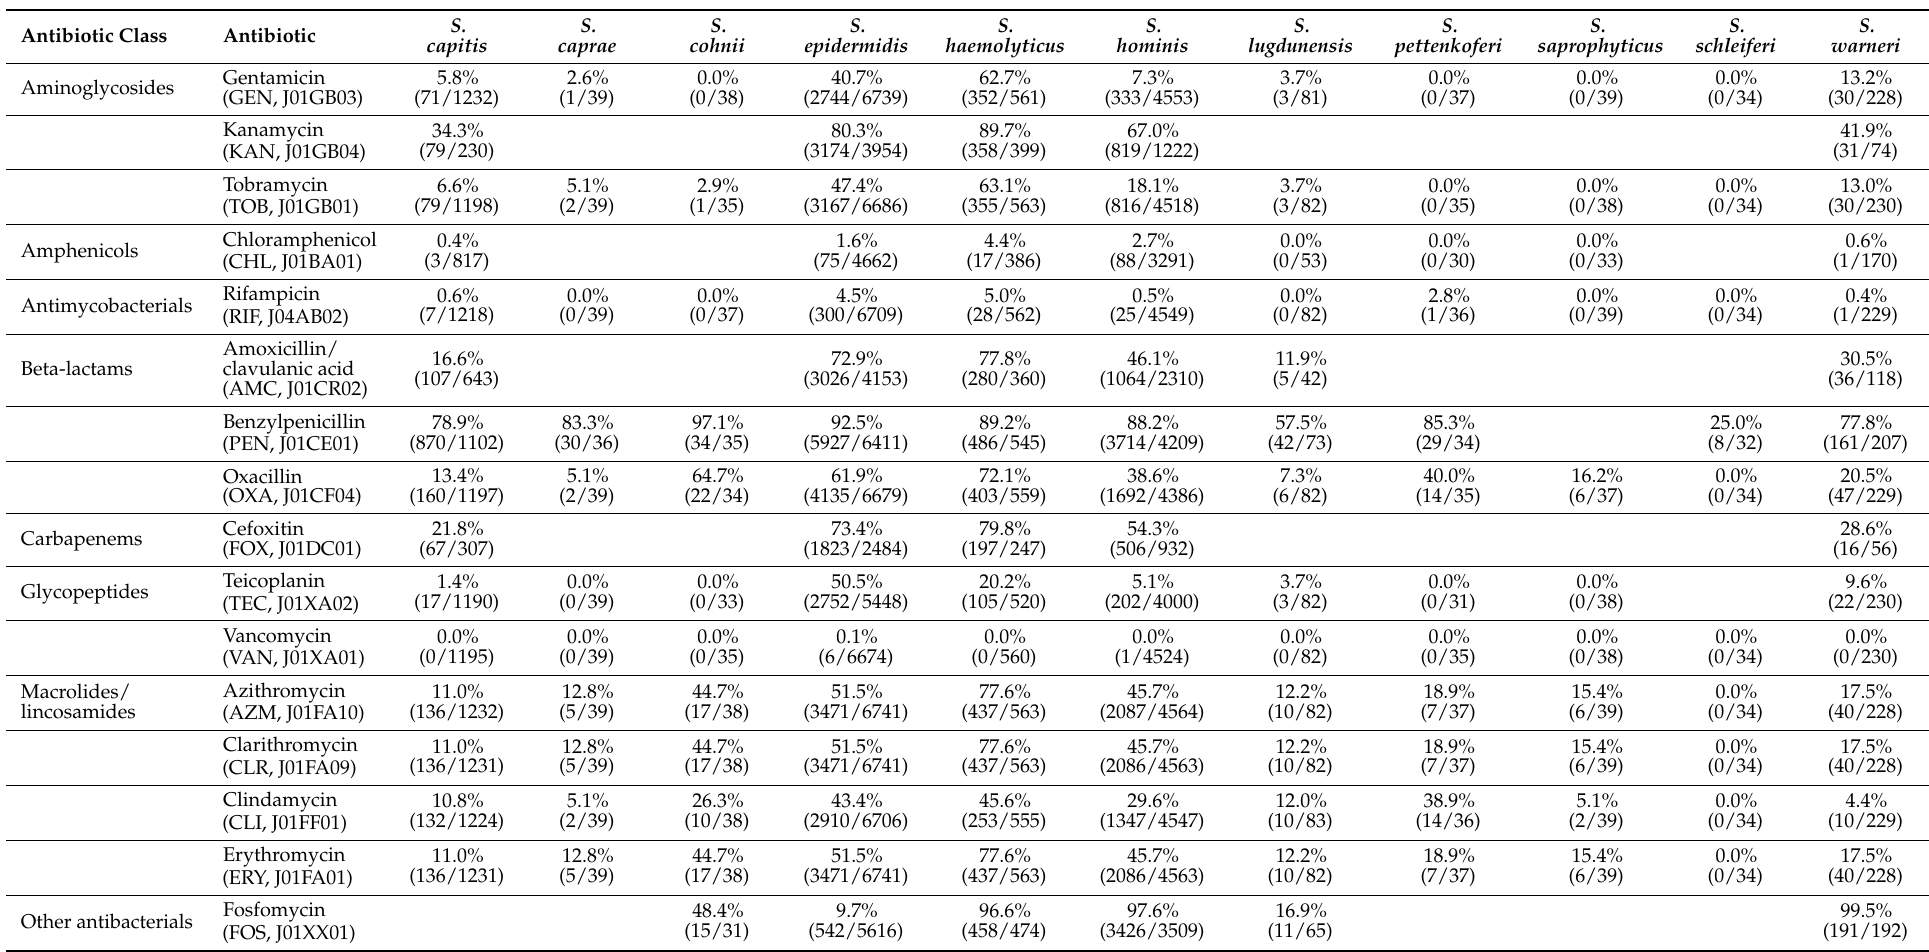
Table 5. Antibiotic resistance in all first weighted CoNS isolates in blood between 2013 and 2019 where at least 30 isolates were available for ABR data analysis. Resistance of 100% denotes intrinsic resistance, as defined by EUCAST. Between parentheses are the number of resistant first weighted isolates and the total number of first weighted isolates for that microorganism-drug combination. The antibiotic names are followed by the official EARS-Net code (European Antimicrobial Resistance Surveillance Network) and ATC code (Anatomical Therapeutic